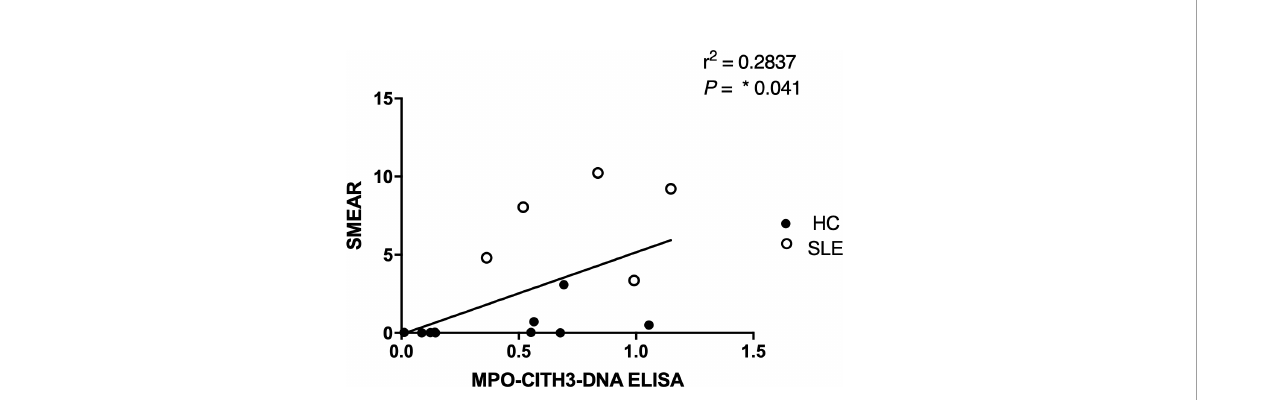
FIGURE 7 Correlation analysis between MPO + CitH3 + DNA ELISA and plasma smear assay across patient samples. Quantity of circulating NETs in healthy control (n = 9) and SLE (n=5) patient samples were measured using the two different assays, and the correlation between assay results was determined. Single data points represent individual donors. Two-tailed correlation analysis between data sets was calculated using Pearson correlation coef fi cients assuming Gaussian distribution in GraphPad Prism 8. R 2 and p-value of linear regression are reported above.